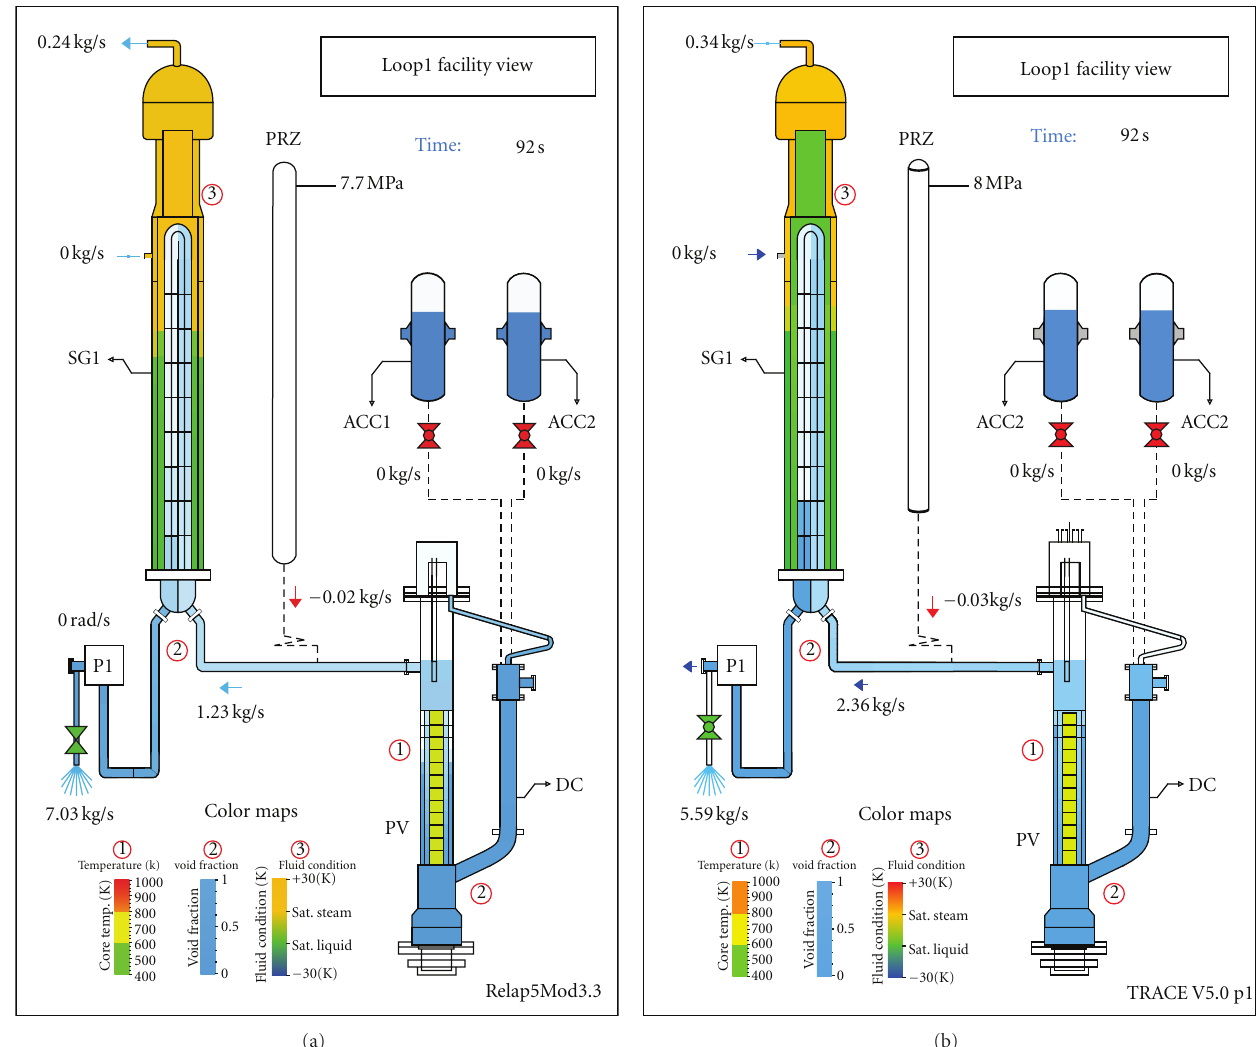
Figure 18: Animation mask for RELAP5 (a) and TRACE (b) at time t = 92 s (first core